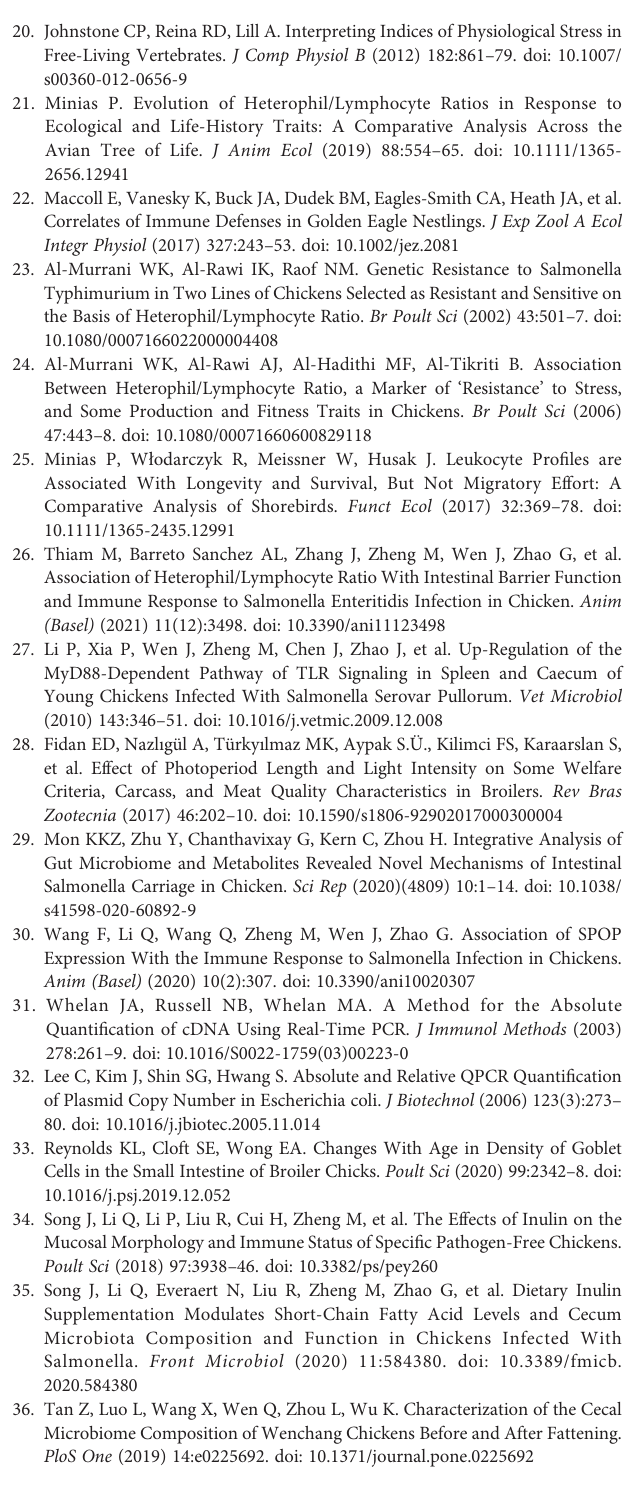
Supplementary Figure 9 | Virulence factors and microbiota species contribution. (A,B) virulencefactorsdifferentiallyabundantbetweenhighandlowH/